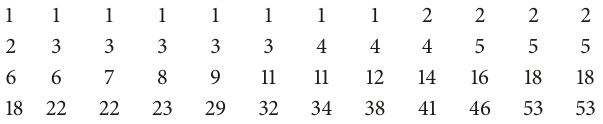
Table 2: Dataset related to the sugarcane harvester’s Pricker.